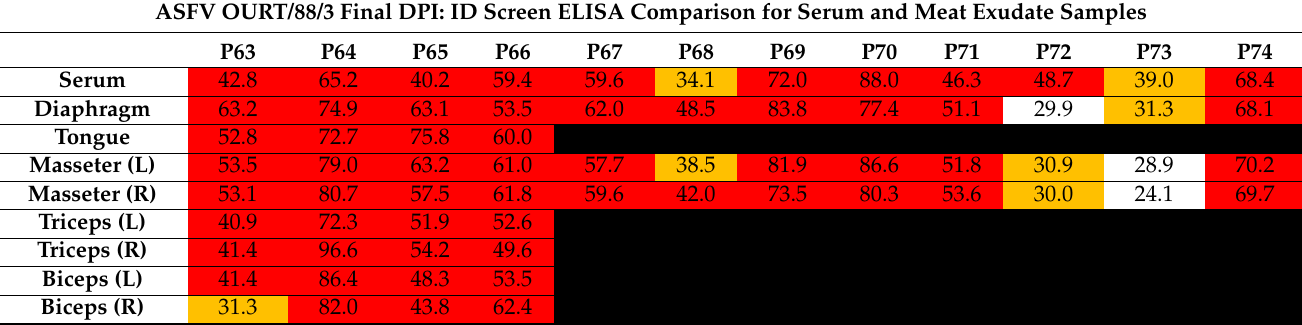
ASFV positivity in serum and meat exudate collected from the diaphragm (Figure 4D) and masseter (Figure 4E) muscles was detected. The number of meat exudate samples from the tongue, triceps, and biceps of the ASFV OURT/88/3-infected pigs was insufficient to perform correlation analysis. Table 3. Side-by-side anti-ASFV antibody levels in the serum and meat exudate from pigs infected with ASFV OURT/88/3. ASFV OURT/88/3 Final DPI: ID Screen ELISA Comparison for Serum and Meat Exudate